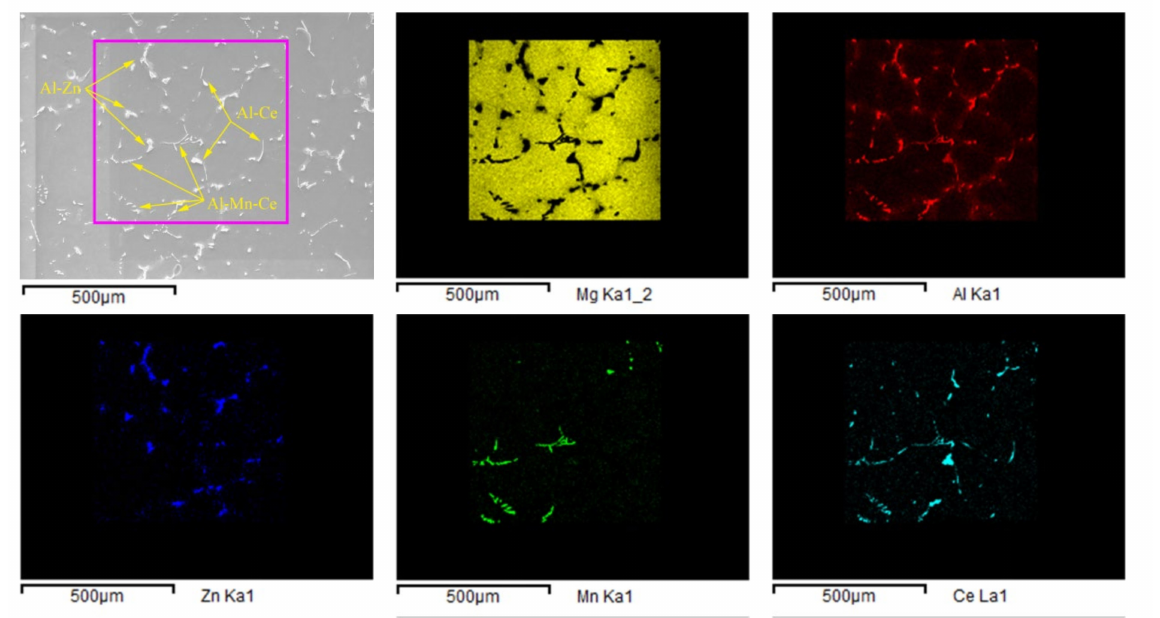
Figure 5. EDS surface scan results of the magnesium alloy with 0.2 wt.% Ce.